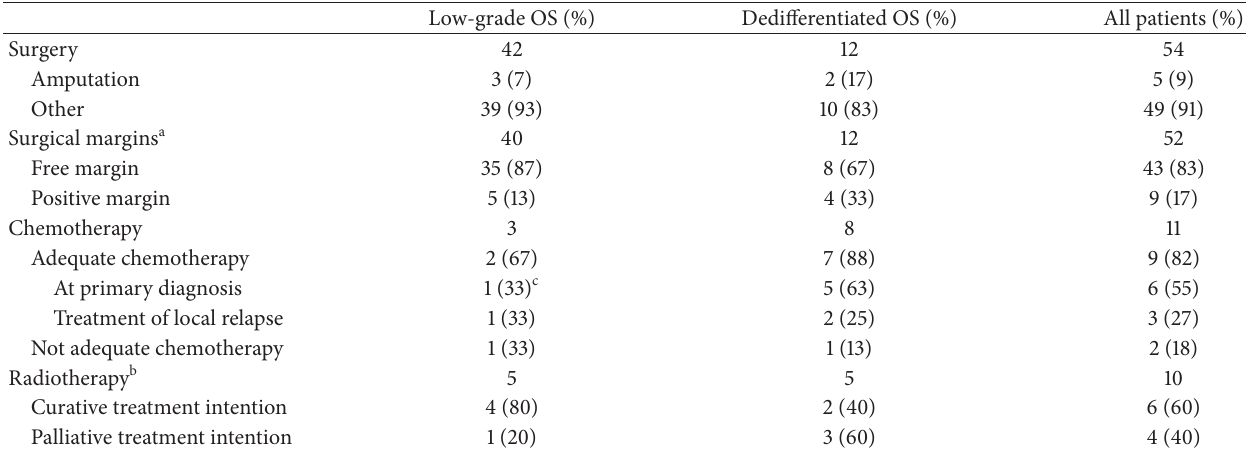
Table 4: Summary of treatment in 54 patients with low-grade or dedifferentiated osteosarcoma (OS). Low-grade OS